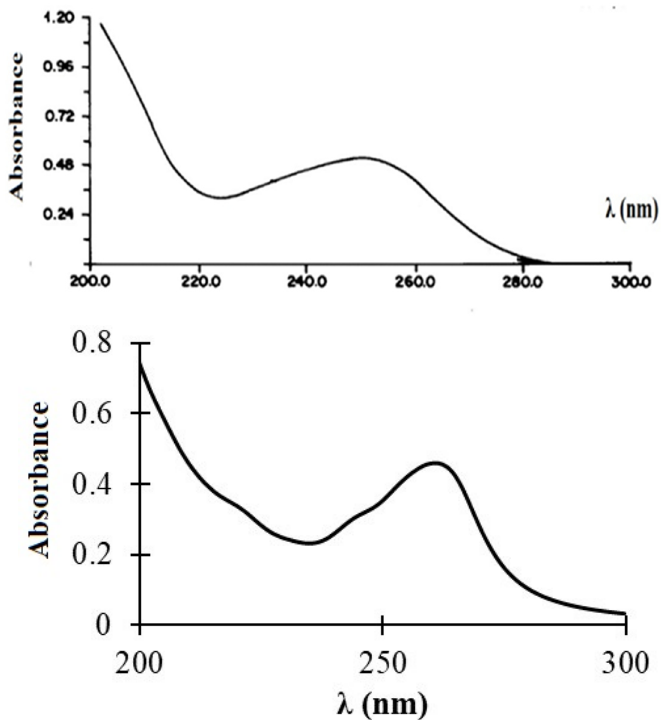
Figure 7. Experimental ( top ) and predicted ( bottom ) UV/Vis spectra of 3 .